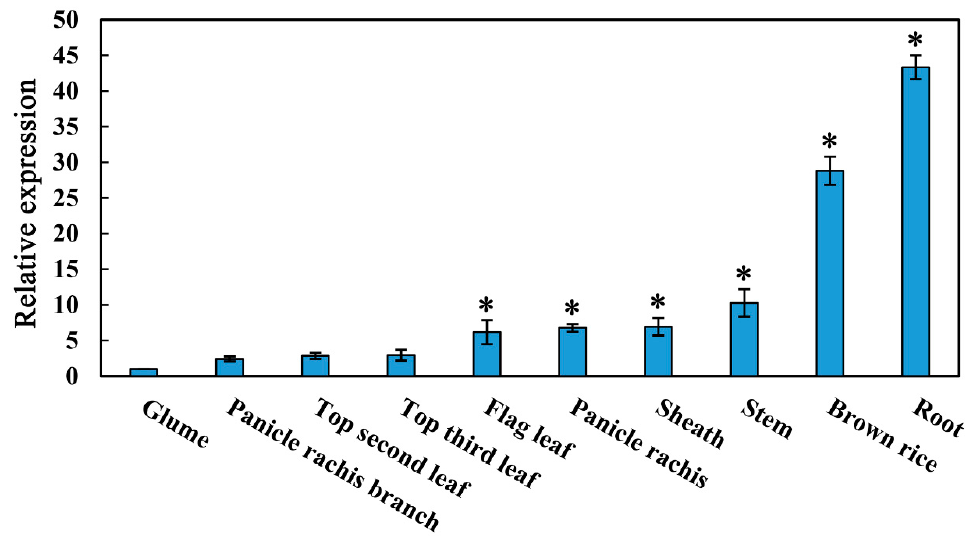
Figure 1. qRT ‐ PCR analysis of the expression of OsMYBAS1 in different rice tissues. Data are mean ± SE of three biological replications. Asterisks indicate statistically significant differences ( P < 0.05, Duncan test) from the control (glume). Actin was used as an internal control.